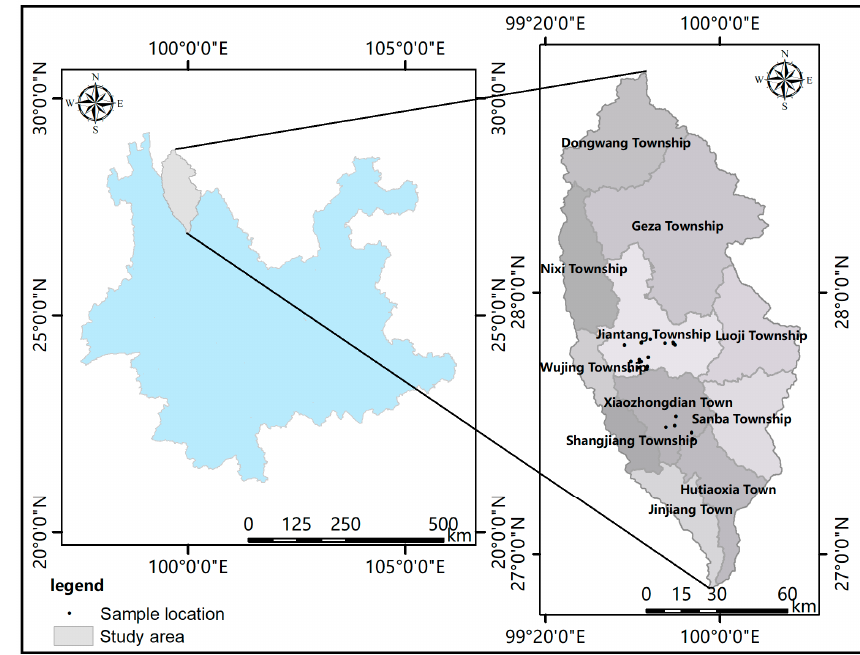
Figure 1. Location of the study area and the sample circles.